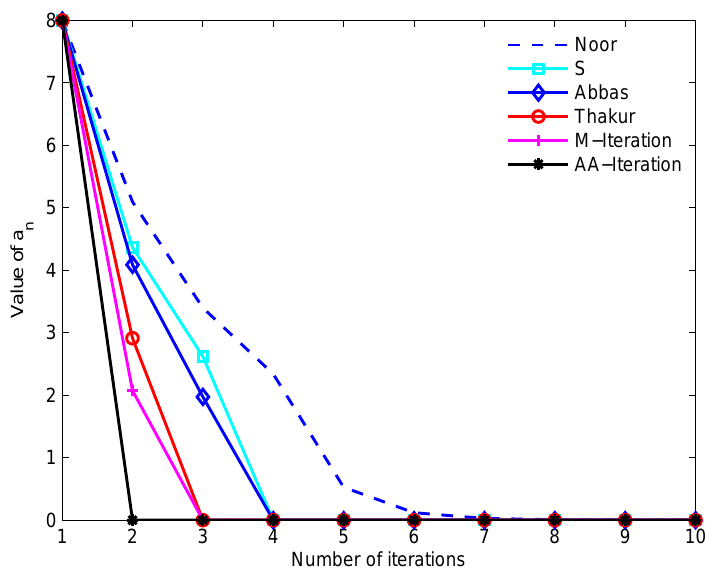
Figure 1. Convergence behavior of iterative